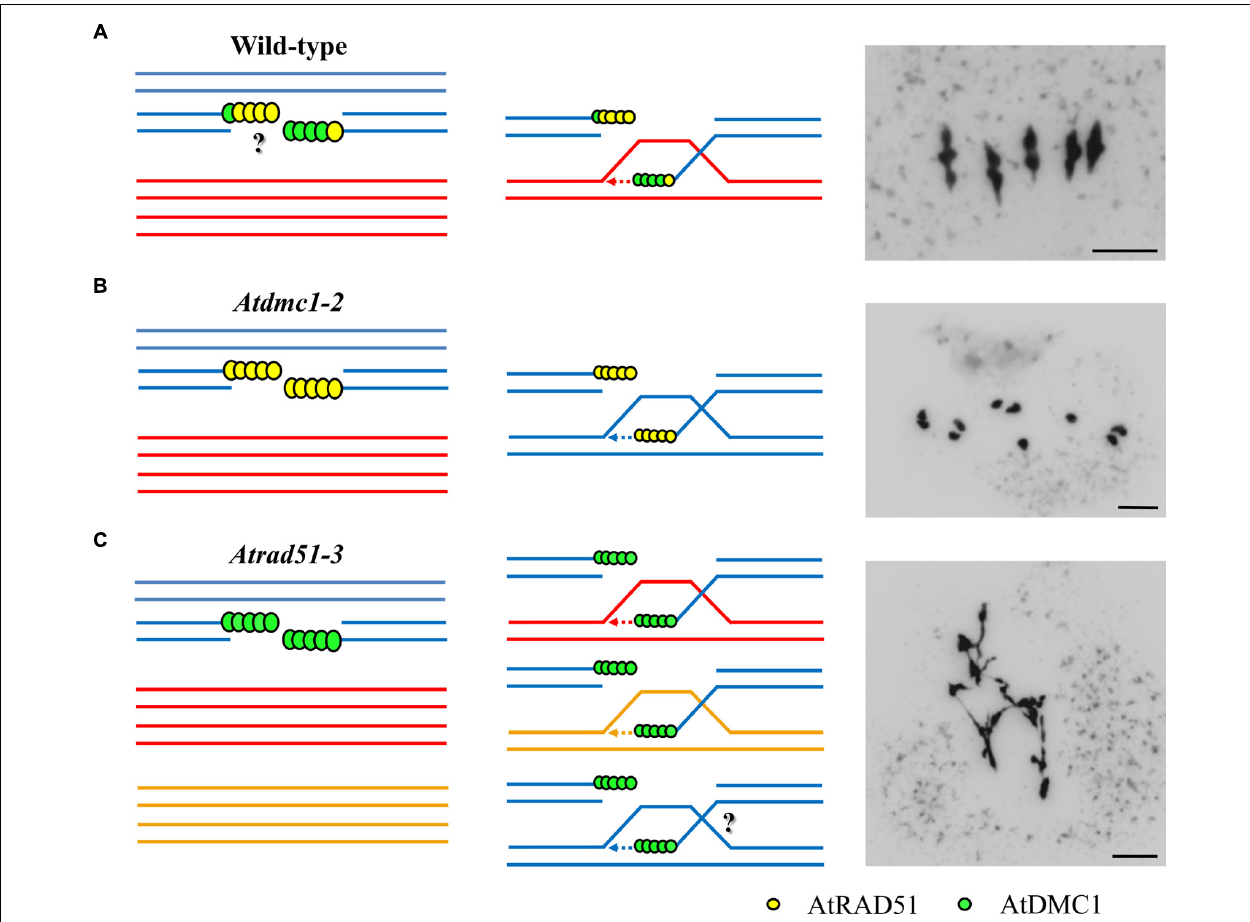
FIGURE 2 | Model for the interplay between AtRAD51 and AtDMC1 during homologous meiotic recombination in Arabidopsis . (A) During WT meiosis, it is not known if AtRAD51 (yellow) and AtDMC1 (green) are loaded asymmetrically at both DNA ends. According to several studies (see text for details) the AtDMC1 nucleofilament would be involved in the first strand invasion, whereas AtRAD51 nucleofilament would be responsible in checking homology during the second end invasion. However, the existence of mixed nucleofilaments could not be ruled out. Five bivalents are observed at metaphase I. (B) In the Atdmc1-2 mutant (Pradillo etal., 2012), all the nucleofilaments are